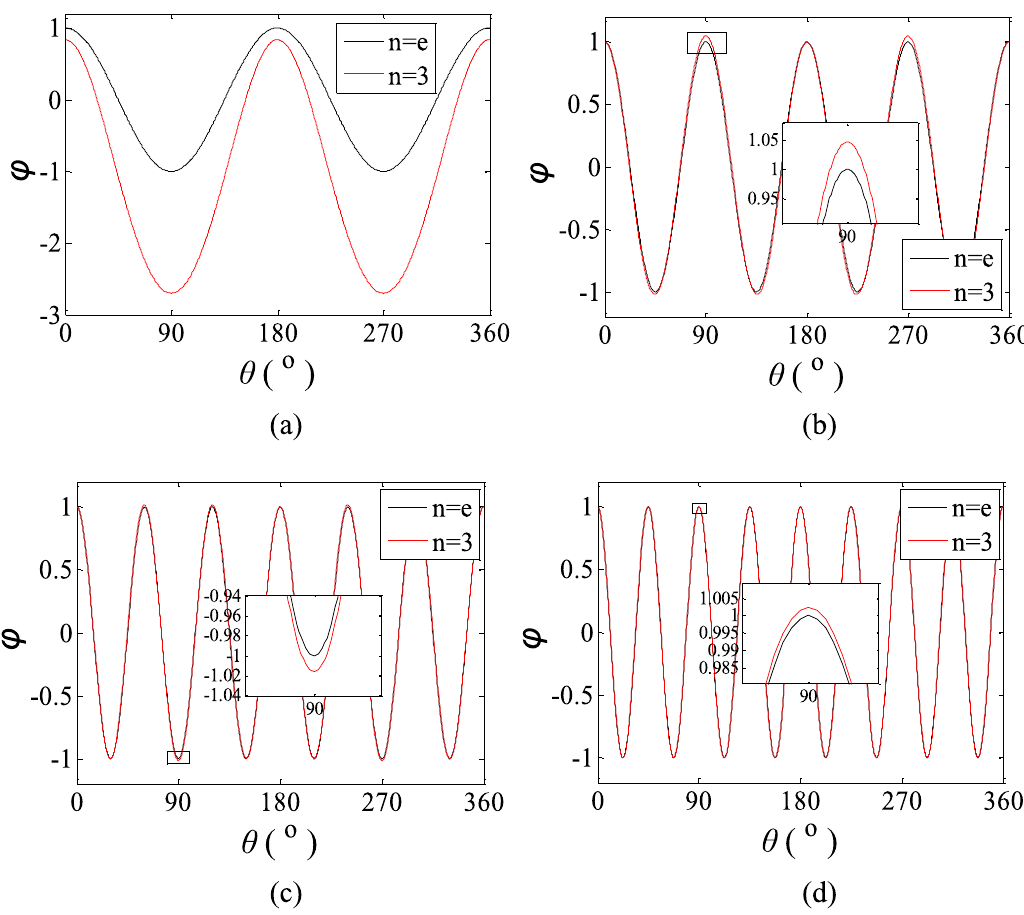
Fig. 3. Differences between modes with and without molecule force. (a) Mode 1 (b) mode 2 (c) mode 3 (d) mode